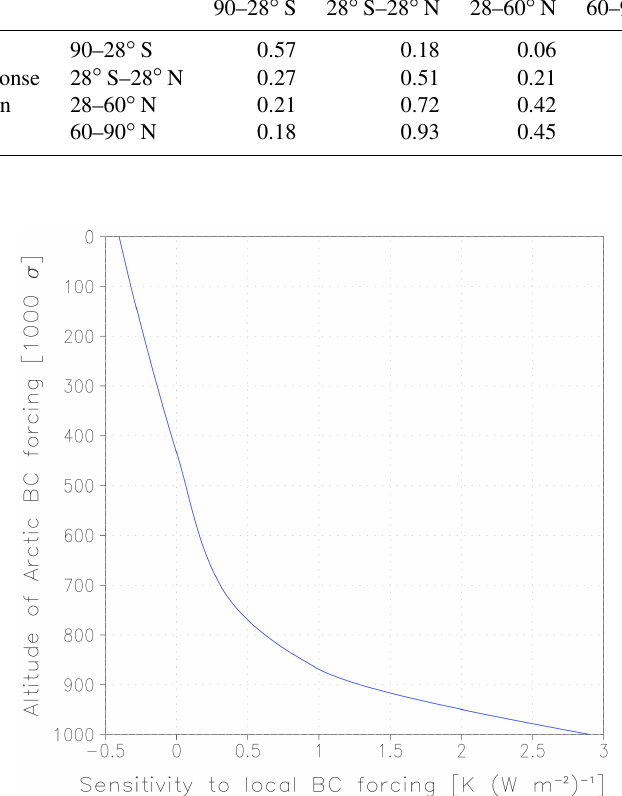
Figure B1. Vertically resolved regional climate sensitivity coefficients describing the Arctic surface temperature response to local BC direct radiative forcing in the Arctic. σ equals the local air pressure normalized by the surface pressure. This is a fit to climate model experiments by Flanner (2013), as originally presented in Fig. S2 of Sand et al.